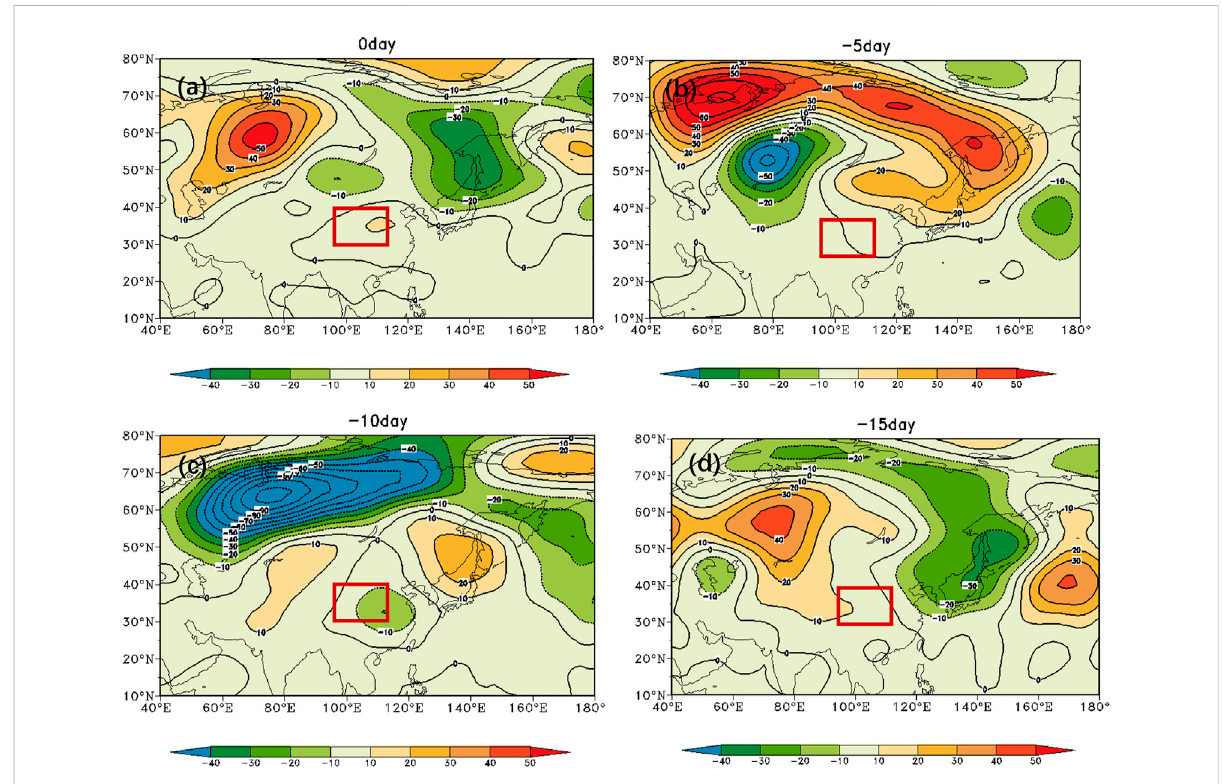
FIGURE 8 Evolutionofthelow-frequency(15 – 30 days)geopotentialheightanomalyat500 hPafrom15 daysbeforetheprecipitationto0 dayafteronset in Basin area, unit: